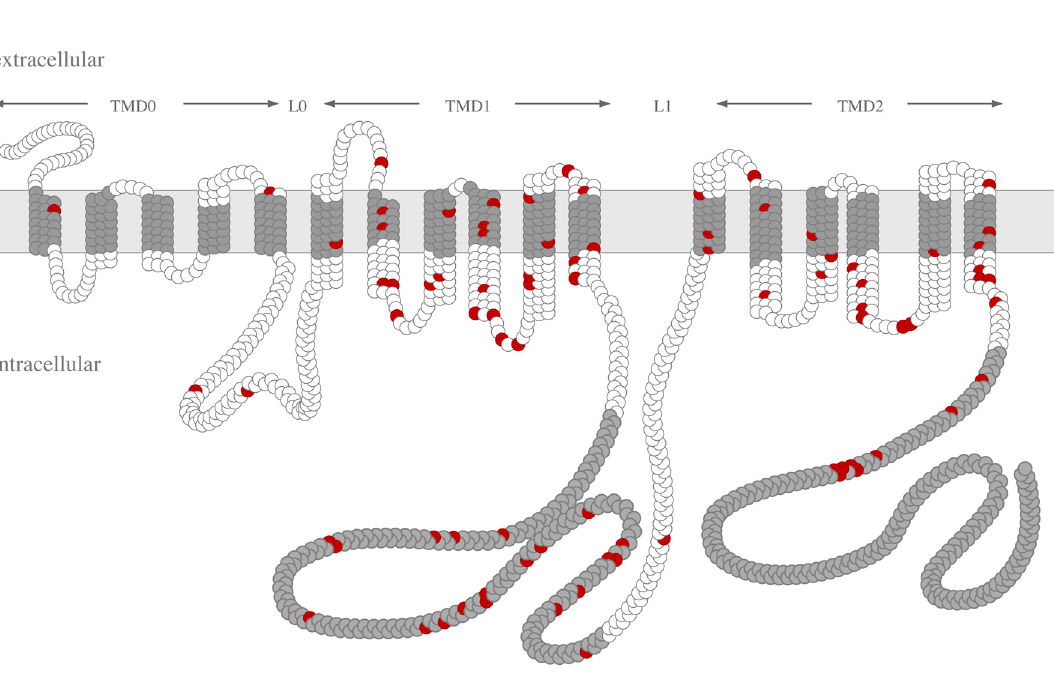
Figure 1. Topology model illustrating the distribution of PXE-associated missense mutations in the ABCC6 protein. Legend: nucleotidE binding domains and the transmembrane helices are shown in grey. Missense mutations are represented in red. The transmembrane domains (TMD0, TMD1, and TMD2) and the linker regions (L0, L1) of the protein are indicated.